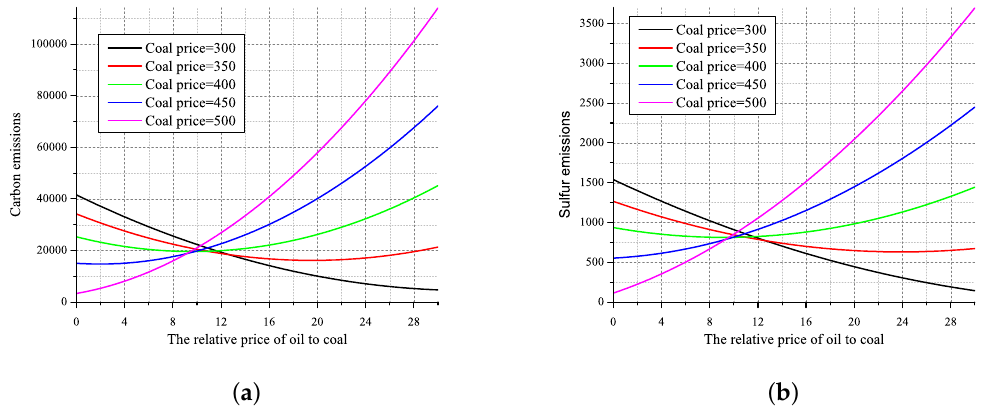
Figure 5. ( a ) The cross-sectional views of W 1 with coal price P 1 between 300–500; ( b ) The cross-sectional views of W 2 with coal price P 1 between